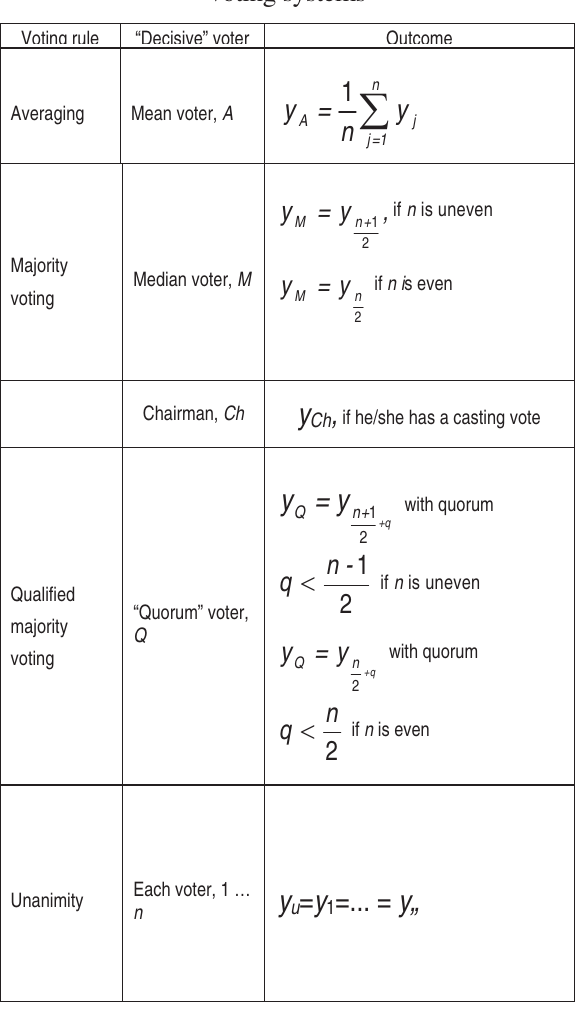
Table 1. Outcome of the vote under alternative voting